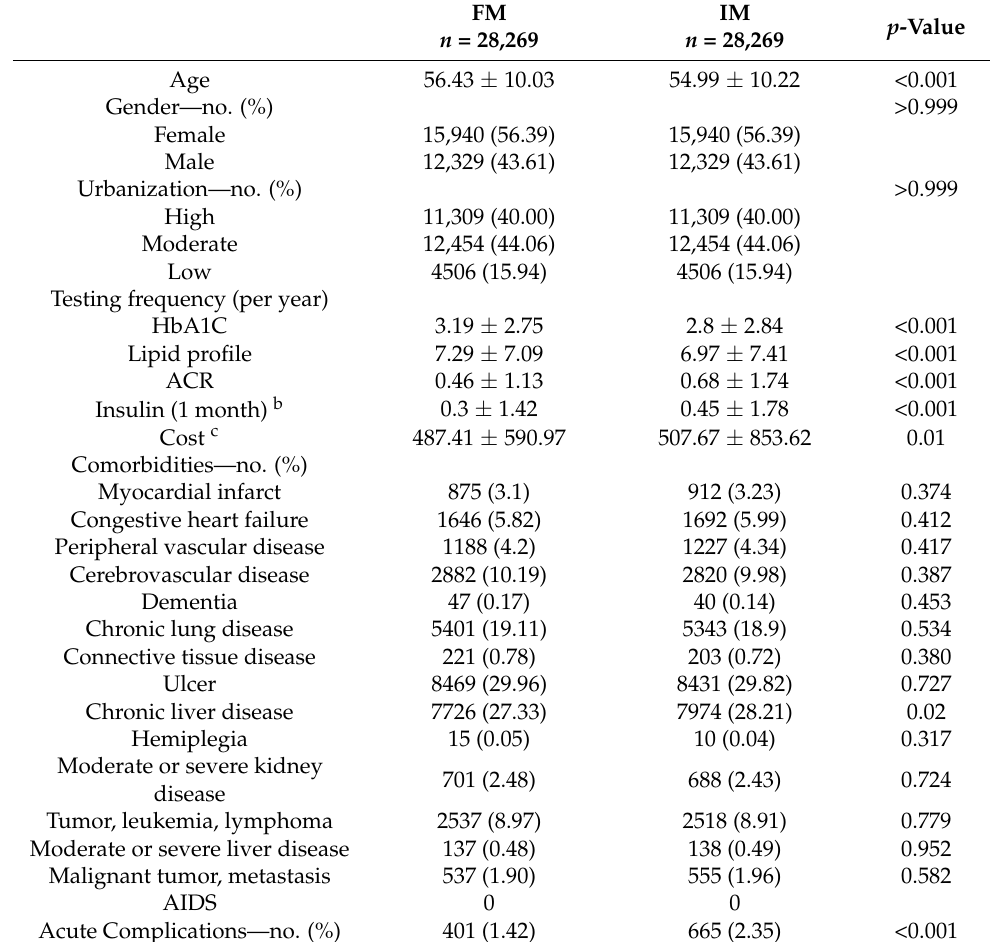
Acute Complications—no. (%)